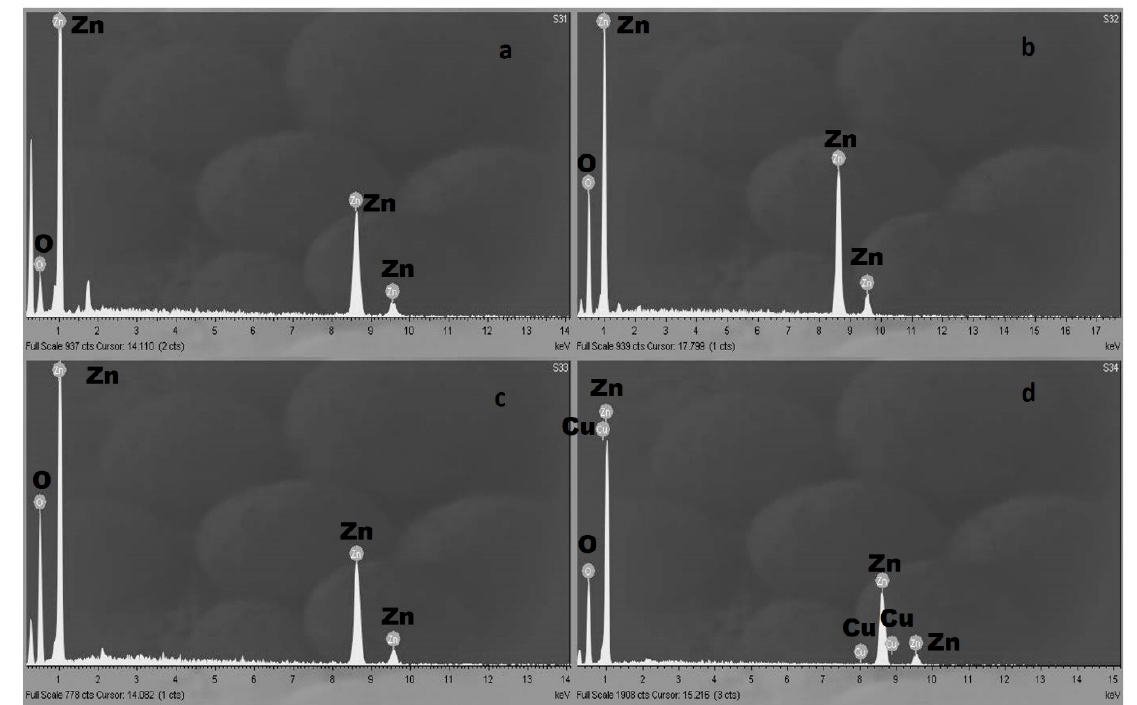
Figure 4. ( a ) A typical EDX spectrum of ZnO synthesized in ethanol, ( b ) a typical EDX spectrum of ZnO synthesized in water, ( c ) a typical EDX spectrum of ZnO synthesized in raki, and ( d ) a typical EDX spectrum of ZnO synthesized in ouzo.